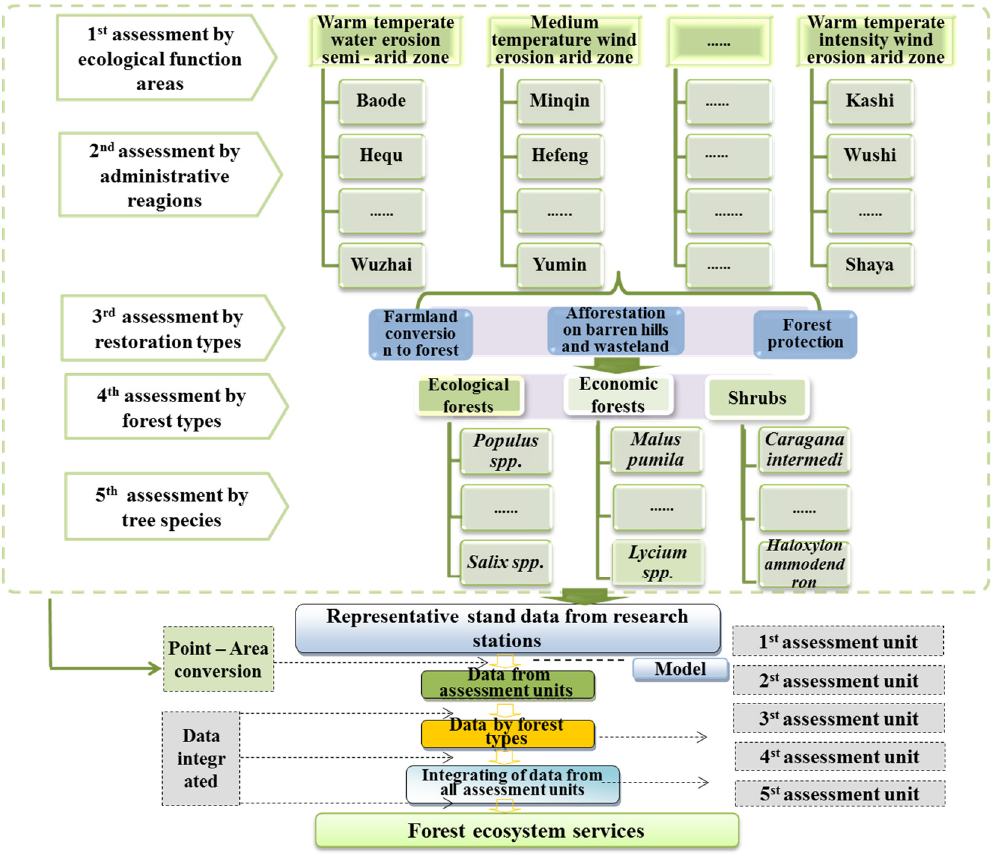
Figure 2. Distributed evaluation system for ecological function areas. Note: The distributed evaluation system for sandstorm path/source was the same as for ecological function areas. Table 3. Distribution of assessment units by assessment levels.